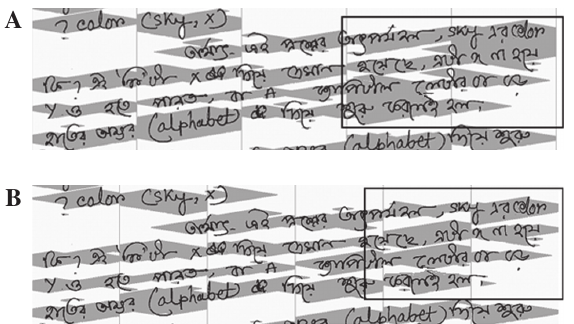
Figure 8. Identified Touching Text Line Segment in a Partition Boundary Shown in (A) Are Separated Almost Accurately in the Following Iteration with Different Partition Structure as Shown in